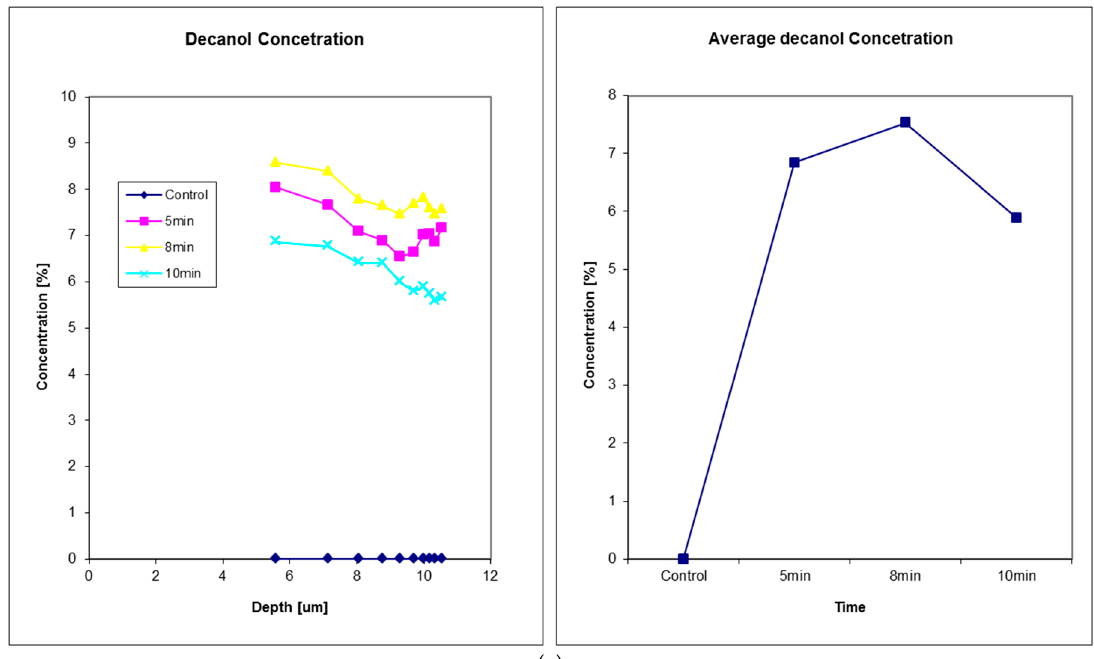
Figure 8. Cont. Figure 8. Cont.